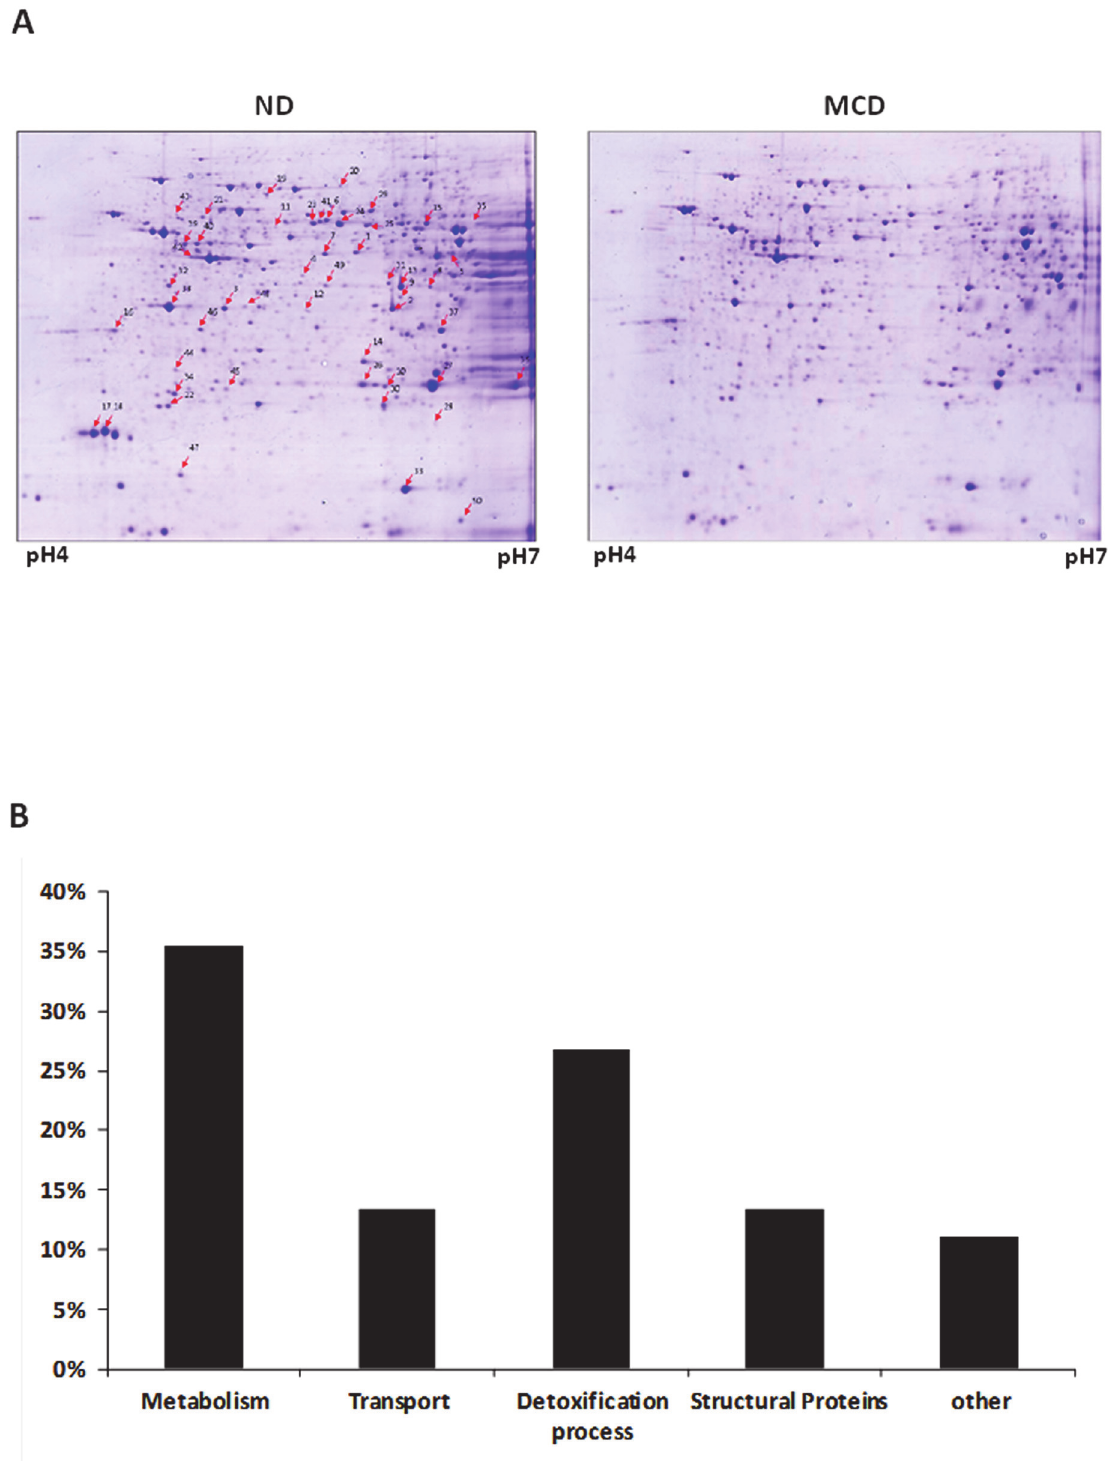
Fig 3. Protein expression map of mouse liver and Classification of the proteins. (A) Coomassie stained 2DE gel shows proteins derived from mice fed ND or MCD. Proteins from mouse liver were loaded on a 24 IPG strip (pH 4 – 7) and then run on an SDS-PAGE (12%). Protein spots noticeably affected by MCD feeding are indicated by arrows. The numbers on the gels correspond to spot numbers in Table 1. (B) Bar graph representing the distribution of the identified proteins according to biological function. Assignments were made based on information from the NCBI (www.ncbi.nlm.nih.gov/PubMed) and the Swiss-Prot/TrEMBL protein knowledgebase (http://au.expasy.org/sport) websites.